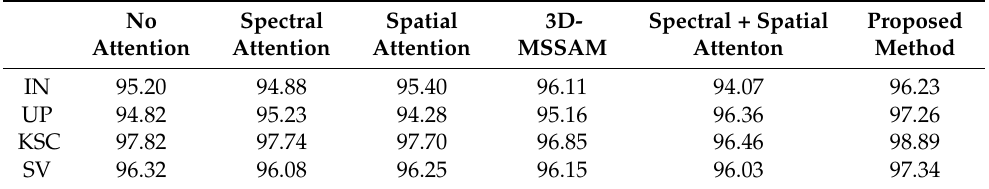
Proposed Method